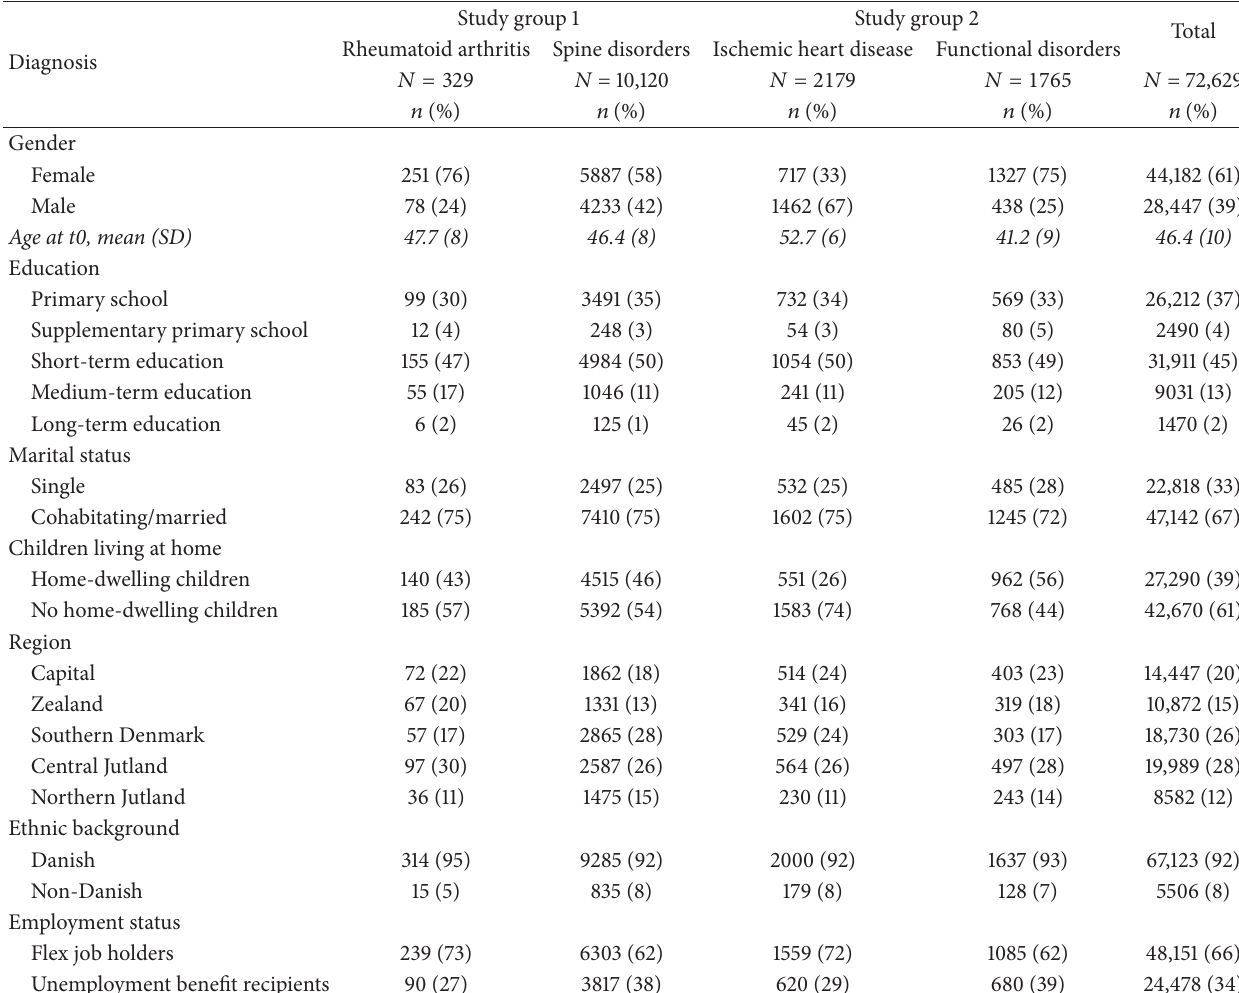
Table 1: Baseline characteristics of study